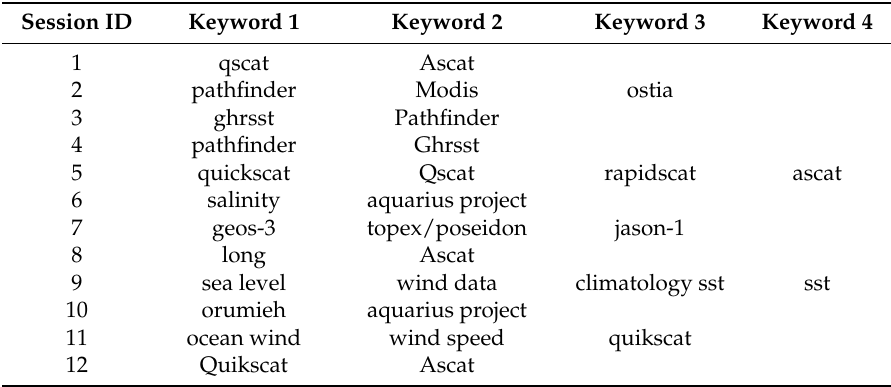
Table 5. Keywords searched in sample